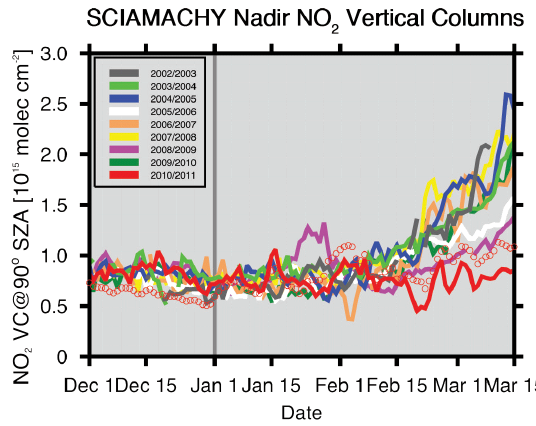
Fig. 11. As in Fig. 10, except for vertical columns of NO 2 at 90 ◦